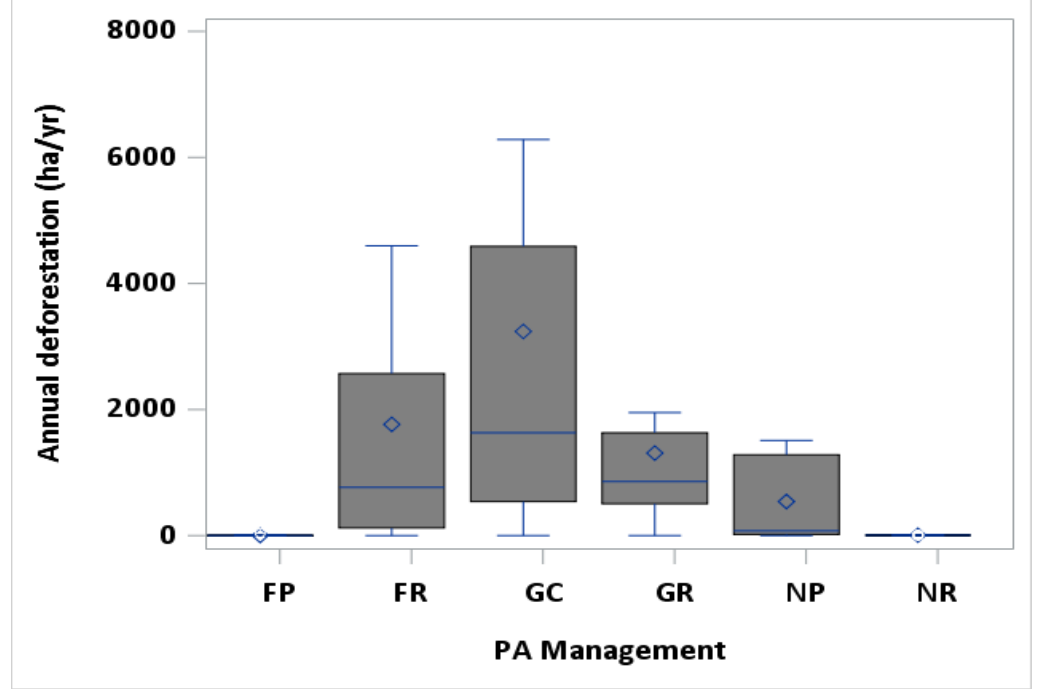
Figure 7. Area ‐ weighted annual deforestation rates (ha/yr) in protected areas of Tanzania ( n /; = 708) and the six PA management regimes namely Forest Plantations (FP), Forest Reserves (FR), Game Controlled areas (GC), Game Reserves (GR), National Parks (NP) and Nature Forest Reserves (NR).The central notched line is the median, and the diamonds are the area ‐ weighted mean; and the whiskers are the lower and the upper confidence limit.